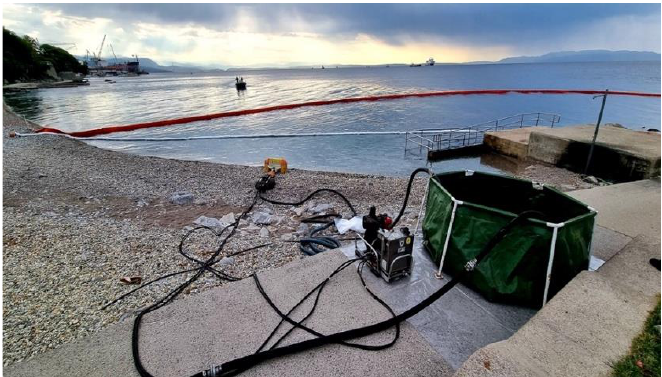
Figure 6 . Testing speed of disc skimmer with additional equipment [Authors].